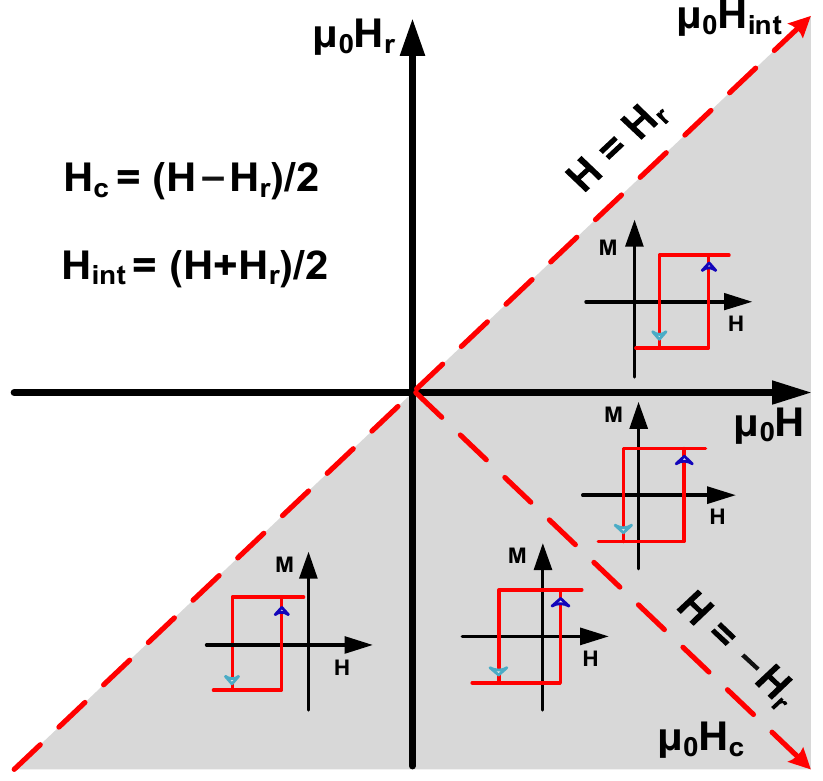
Figure 4. Two-dimensional coordinate system composed of H and H r , and coordinate of switching field and interaction field with a rotation angle of 45 ◦ composed of H c and H int